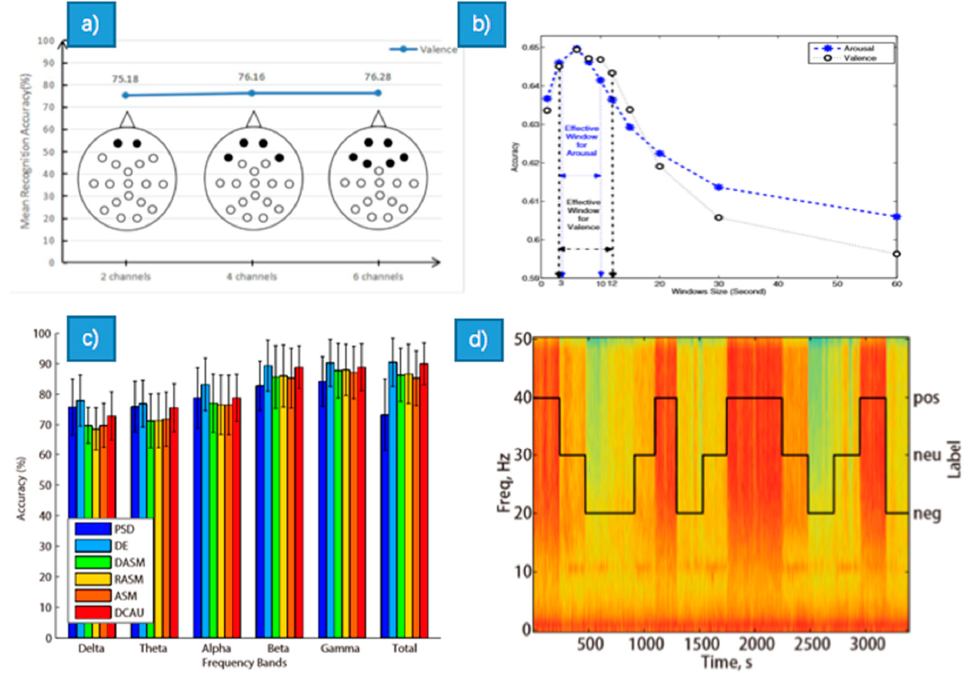
Figure 6. ( a ) Mean accuracy of different channels; ( b ) The performance of different windows sizes; ( c ) The average accuracies of GELM; ( d ) Spectrogram shows different patterns with different emotions.